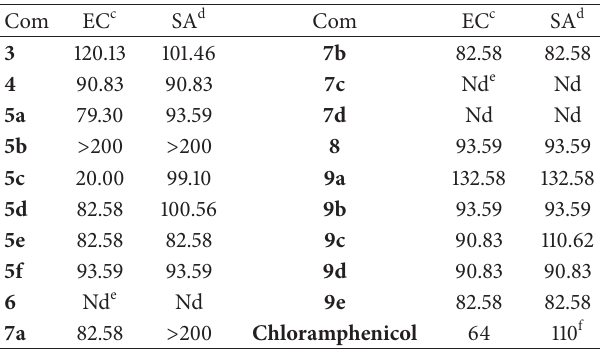
Table 1: MIC a,b ofbutenolide derivatives against Escherichia coli and Staphylococcus aureus